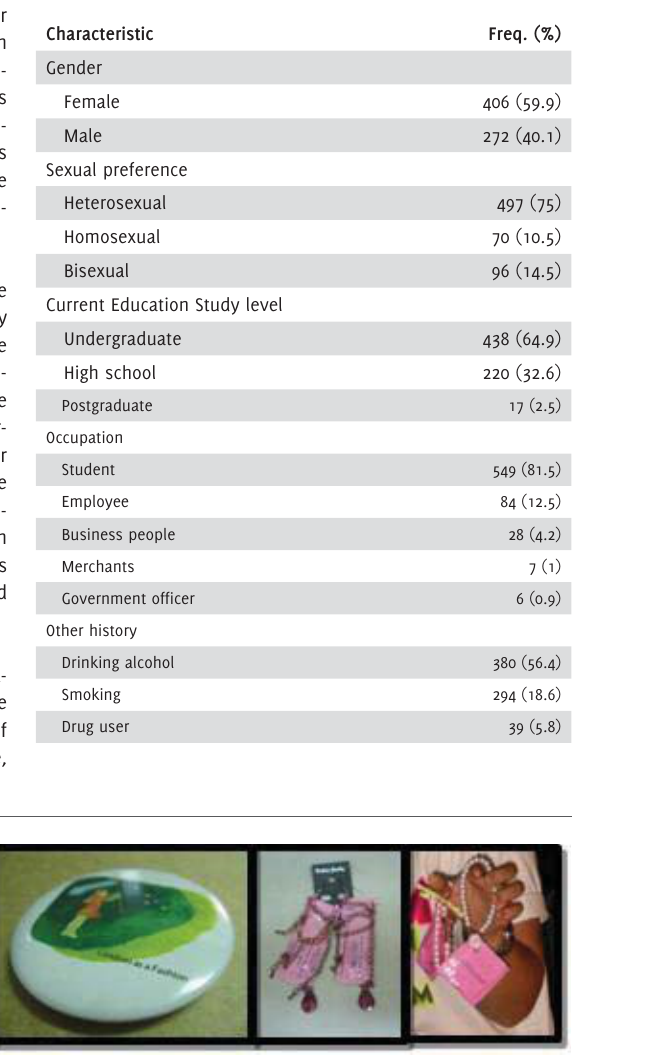
Table 1. Socio-demographic characteristics of participants.